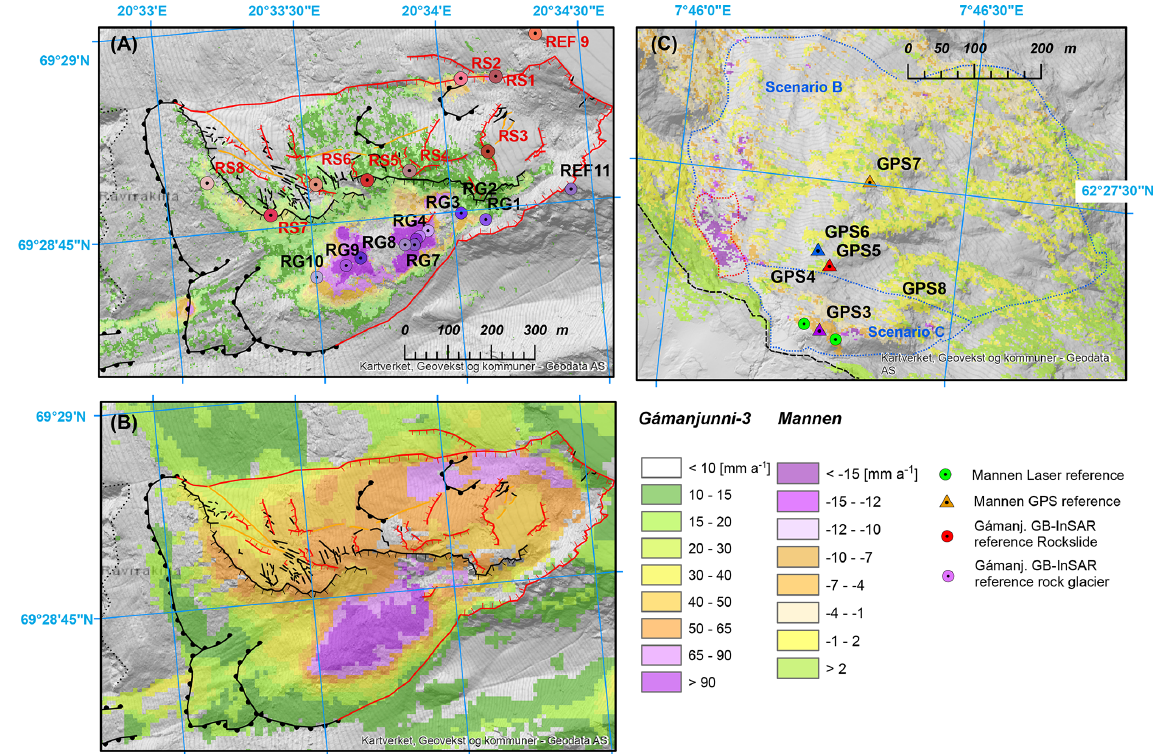
Figure 6. Spatial distribution of displacement rates for Gámanjunni-3 (a, b) and Mannen (c) . (a) The GB InSAR map is an average for the summer 2020. The circles indicate the position of time series sampling shown in Fig. 5 on the rockslide (red) and the rock glacier (violet). The colour depth indicates relative differences in velocity. (b) Satellite 2D InSAR-derived averaged summer displacement rates collected between 2009 and 2014 using TerraSAR-X (Eriksen et al., 2017). Both show clearly higher velocities in the rock glacier area. (c) GB InSAR displacement rates along GB radar LOS of the Mannen instability from summer 2020, showing relatively low displacement rates outside the upper scar area. The recently failed rockslide Veslemannen (Kristensen et al., 2021) is delineated by the dotted red line. The dashed black line indicates the upper scarp area. The failure scenarios are based on Dahle et al. (2008). Note the different velocity scales for Gámanjunni-3 and Mannen. All base maps from © Statens